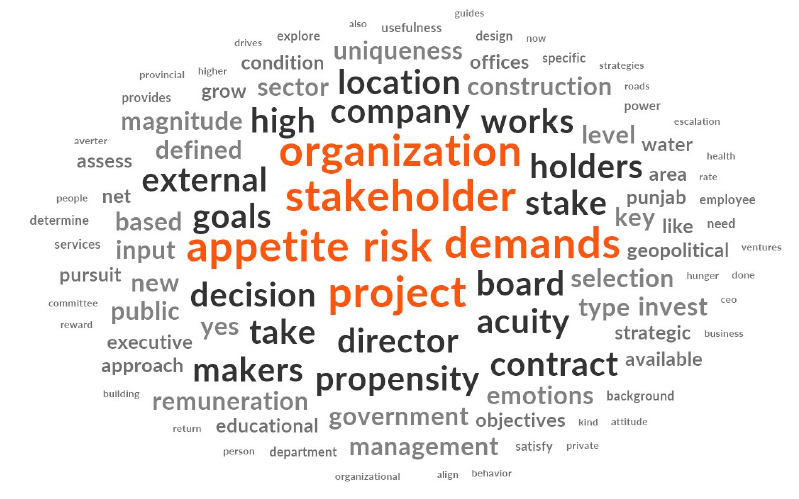
Figure 7. NVIVO codes words cloud.